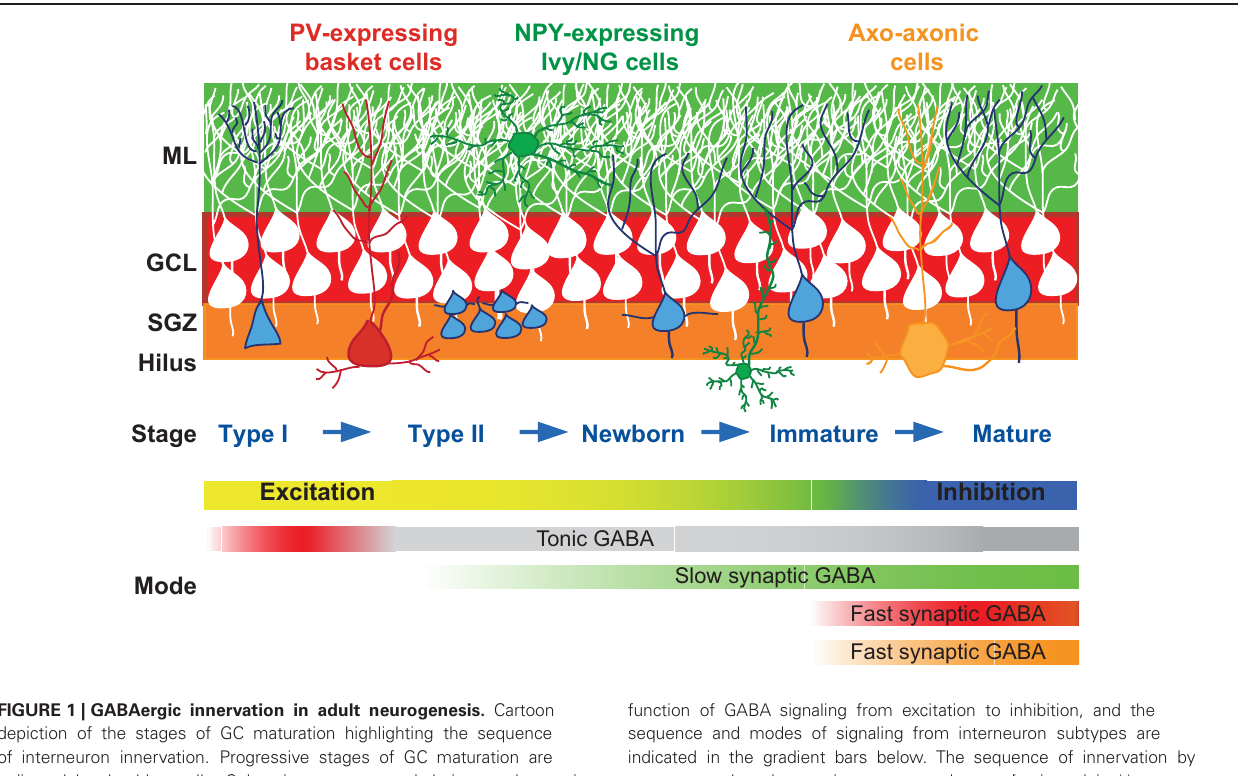
FIGURE 1 | GABAergic innervation in adult neurogenesis. Cartoon depiction of the stages of GC maturation highlighting the sequence of interneuron innervation. Progressive stages of GC maturation are indicated by the blue cells. Select interneurons and their axonal targeting regions are indicated by the corresponding shaded areas (red, PV + basket cells; green, Ivy/NG cells; orange, axo-axonal cells). The shift in